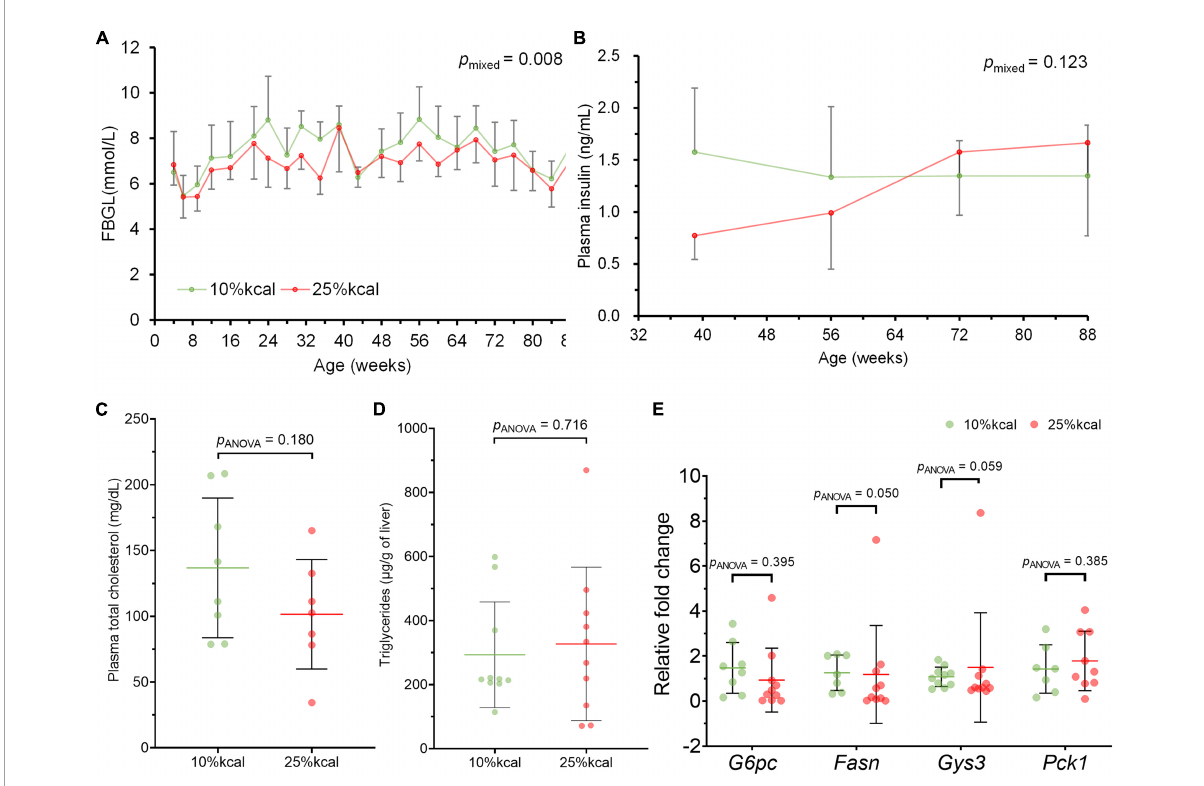
FIGURE3 Intake of 25% kcal sucrose diet does not cause hyperglycemia and dyslipidemia and disrupt expression of related genes in male C57BL/6N mice, compared with a 10% kcal sucrose. (A) Fasting blood glucose level (FBGL; n = 10 in each group at the start, see Supplementary Table 1 for n at each timepoint), (B) fasting plasma insulin level ( n = 9 in each group for weeks 39, 56, and 72; n = 3 in each group at week 88); and (C) fasting plasma total cholesterol ( n = 10 in each group); (D) liver triglycerides ( n = 8 in 10% kcal and 7 in 25% kcal); and (E) hepatic expression of G6pc ( n = 8 in 10% kcal and 10 in 25% kcal), Fasn ( n = 7 in 10% kcal and 9 in 25% kcal), Gys3 ( n = 10 in each group), and Pck1 ( n = 7 in 10% kcal and 8 in 25% kcal) of male C57BL/6N at time of sacrifice (week 87–104). Values are presented as mean ± SD. Differences between groups were tested using linear mixed model for time-series analysis, and one-way ANOVA for single timepoint analysis. RFC, relative fold